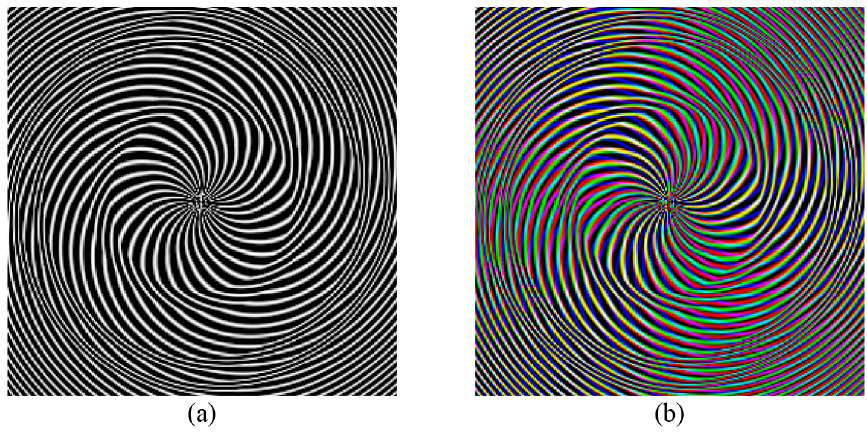
Figure 1. The DSFs phase function ( a ) gray version and ( b ) RGB color